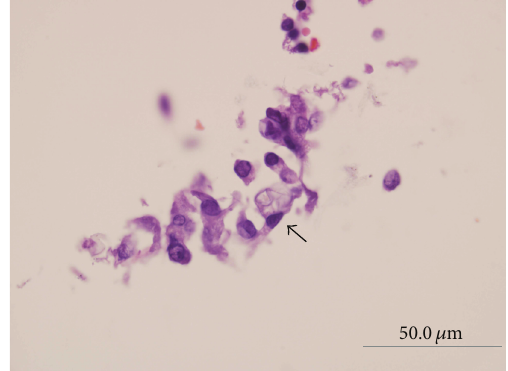
Figure 4: 1000x brain. A detached fragmented inflammatory focus of scattered histiocytes and few lymphocytes with extracellular, refractile, and round to oval thick-walled algal organism (arrow) which is 10–15 𝜇 m in diameter and composed of 2 to 3 wedge-shaped endospores is demonstrated. Hematoxylin and eosin stain: